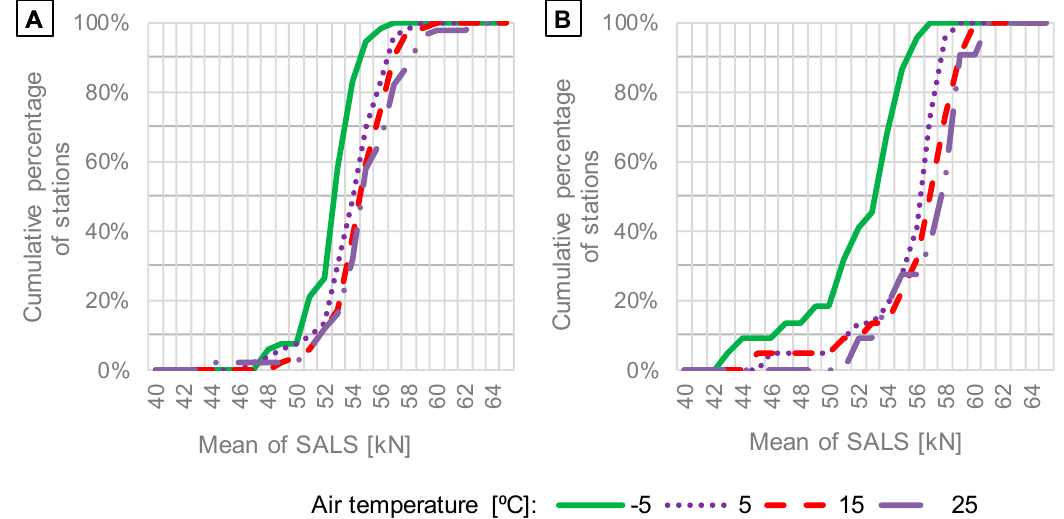
Figure 7 . Distributions of mean values of SALS in relation to air temperature based on data from WIM systems equipped with: ( A ) quartz piezoelectric; ( B ) bending beam axle load sensors.